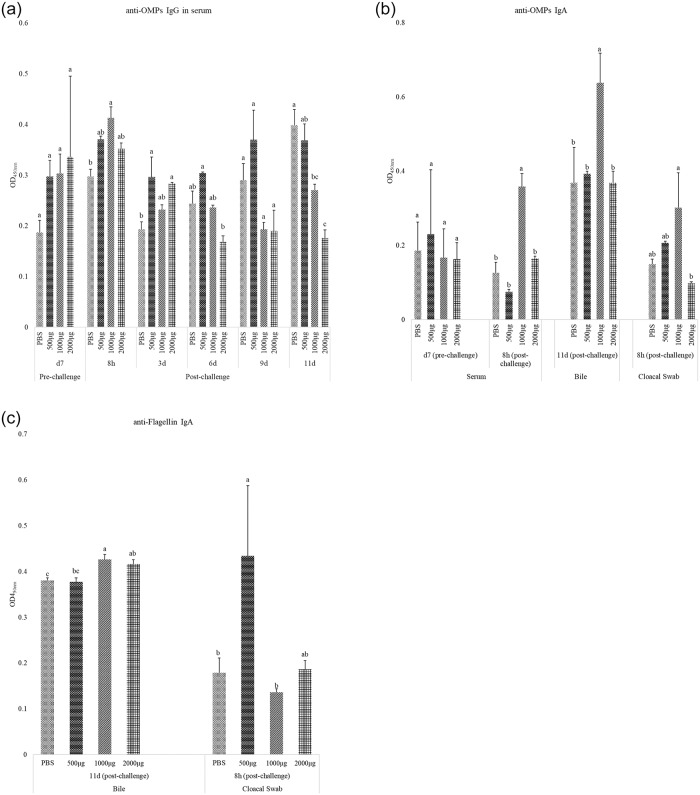
Effect of CNP-S. Enteritidis vaccine on anti-Salmonella IgG and IgA antibody levels.At 1d of age, chickens were orally vaccinated with either PBS (control-challenged) or different doses of outer membrane + flagellin proteins: 500μg, 1000 μg, or 2000 μg, loaded into CNP. The same route of delivery and doses was repeated at d7 of age. At d14 of age, birds were challenged with live S. Enteritidis (5.4 x 105 CFU/bird). Blood, bile and cloacal swab samples were collected pre- and post-challenge and analyzed for anti-Salmonella antigen-specific IgG and IgA levels using ELISA. Results were reported as average optical density (OD) values. A–OMPs IgG; B–OMPs IgA; C–Flagellin IgA. Bars (+ SE) with no common superscript differ (P<0.05). n = 3 to 5.